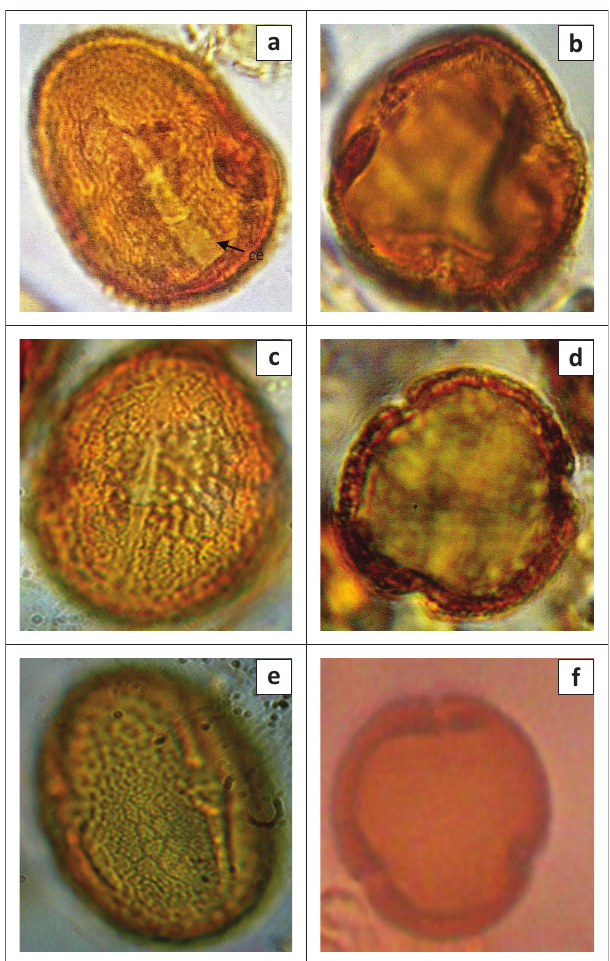
FIGURE 2: Microphotograph of the pollen grains of West African species of Desplatsia